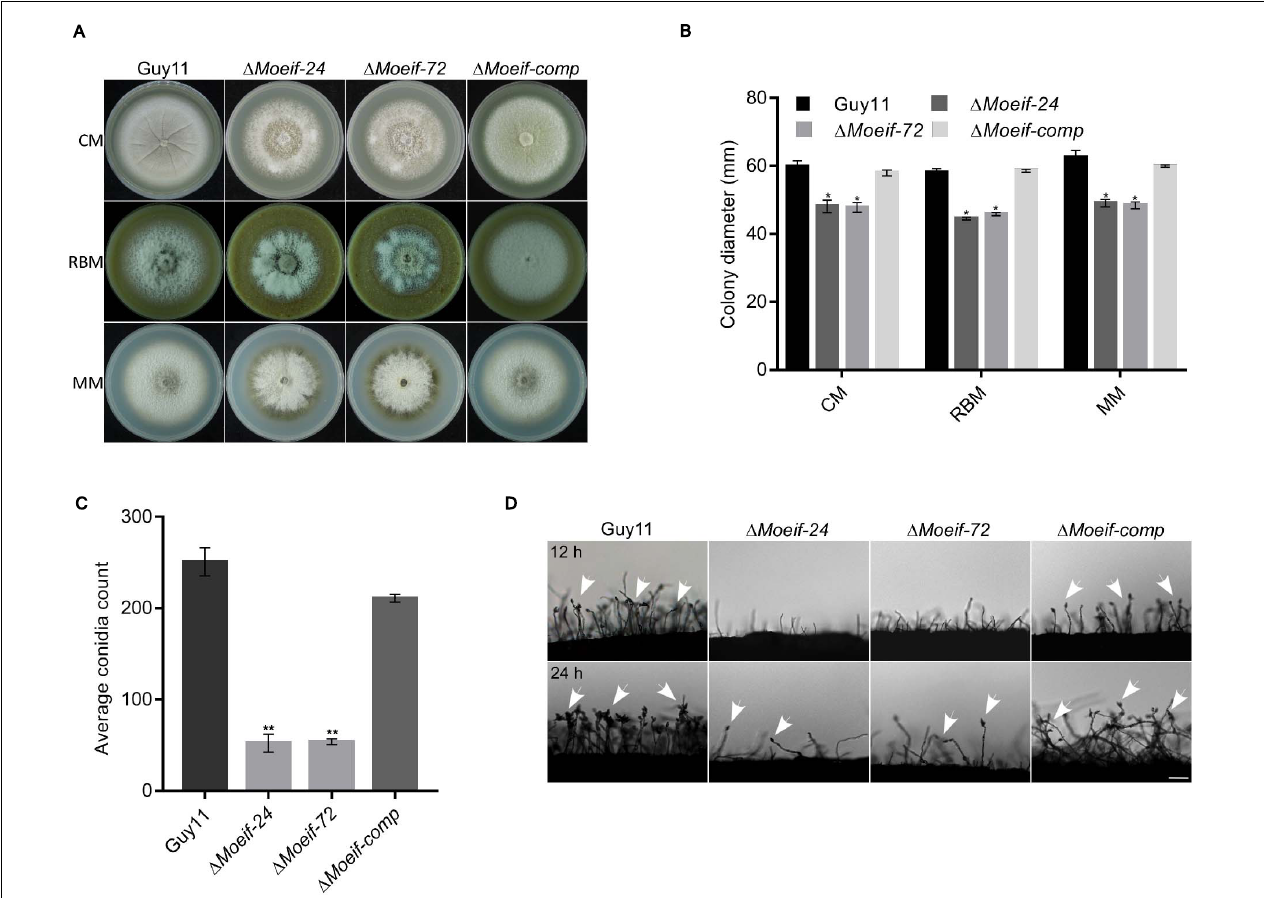
FIGURE 4 | MoeIF4E3 contributes significantly to the vegetative growth and conidiogenesis of M. oryzae. (A) Depicts the average colony diameter and morphology of (cid:49) MoeIF4E3 mutants ( (cid:49) Moeif-24 , (cid:49) Moeif-72 ), complemented strain (cid:49) Moeif-comp and the wild-type Guy11 strain cultured on CM, RBM, and MM for 10 days. (B) Statistical demonstration of the average growth rate of respective mutant strains and the wild-type Guy11 on CM, RBM, and MM for 10 days. (C) A statistical representation of conidiation capacity of MoeIF4E3 gene deletion strains and their complement relative to the Guy11 wild-type strain. (D) The reduction in conidiophore and conidia-bearing capabilities of conidiophores of the strains on rice bran medium. The statistical data were analyzed with a Microsoft Excel spreadsheet and GraphPad-prism7. Error bars represent the standard deviation from at least three independent replicates, and (*) and (**) represent significant differences ( p < 0.05 and p < 0.01, respectively) between the wild type Guy11 and the respective knockout mutants according to ordinary one-way ANOVA. Bar, 10 µ